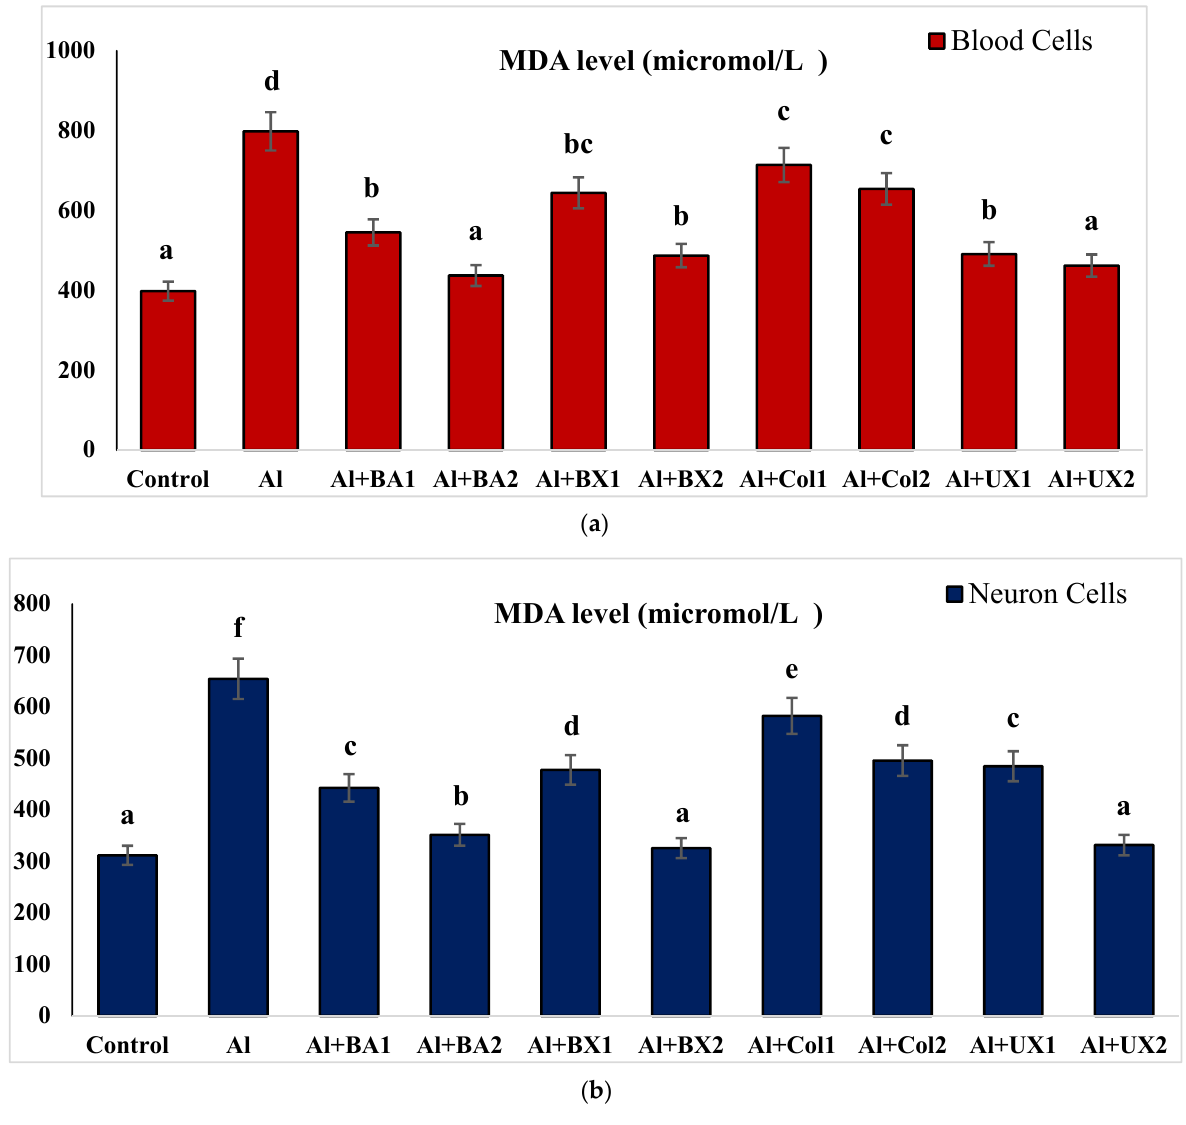
Figure 6. The effect of Al and boron treatments in ( a ) human blood and ( b ) PRCNs on TOS levels. Abbreviations are as in Figure 2. (Each superscript letter (a, b, c, d, e) represents statistically similar groups).